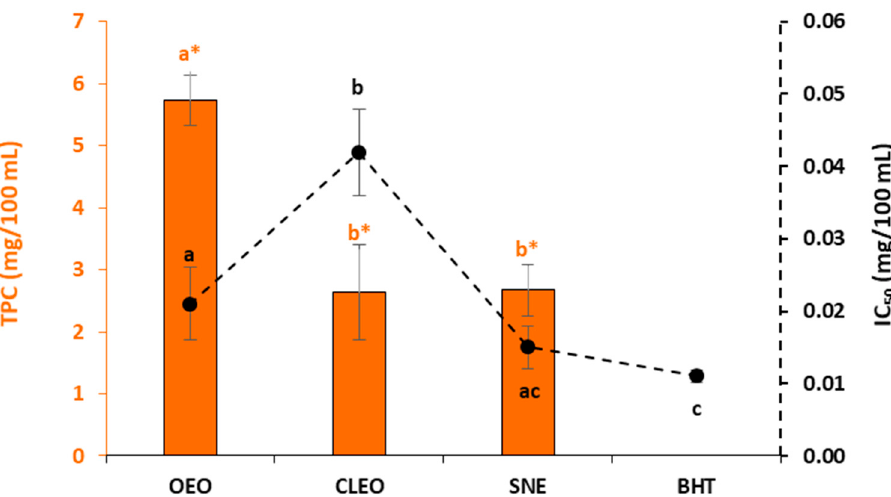
Figure 1. Total phenolic content (TPC) ( ■ ) and antioxidant capacity expressed as IC 50 values of the 2,2-diphenyl-1-picrylhydrazyl (DPPH) ▪ scavenging activity ( ● ) in oregano essential oil (OEO), clove essential oil (CLEO), S. nigra flower extract (SNE) and butylhydroxytoluene (BHT) (mean ± SD). Different letters mean significant differences (orange letters with asterisks for the TPC and black letters without asterisks for the IC 50 values).